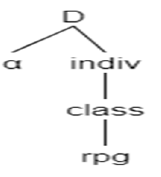
Figure 5. Geometry of D.